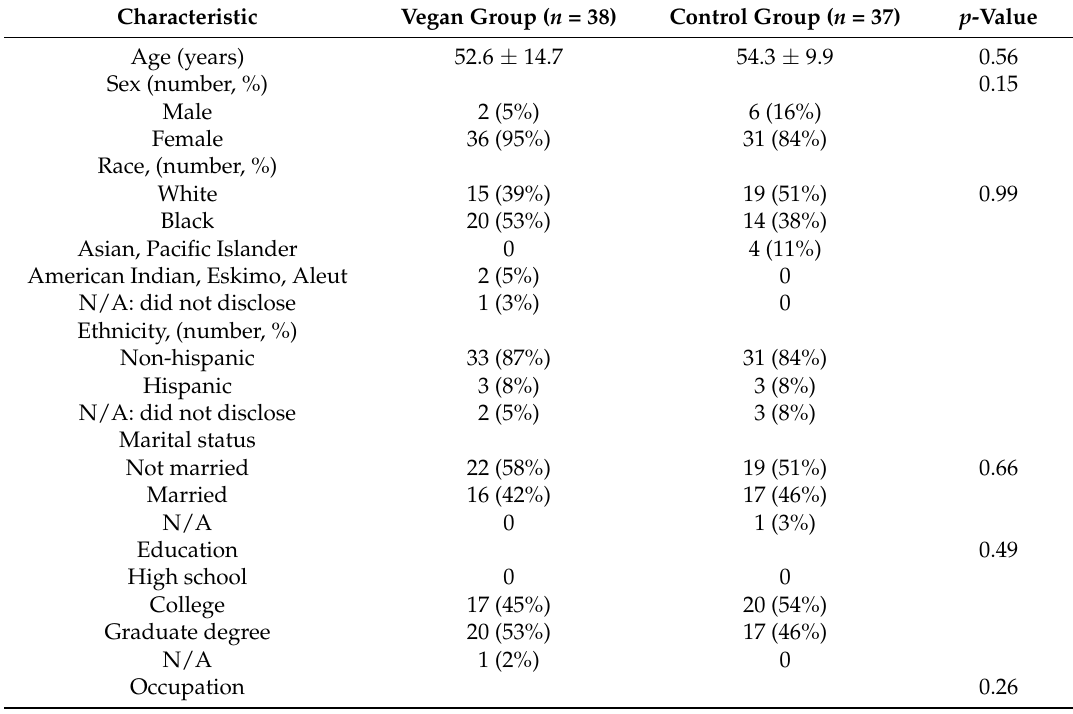
Figure 1. Enrollment of the Participants and Completion of the Study. Table 1. Baseline characteristics of the Study Population. Data are means ± SD, or number (%). p -values refer to t-tests for continuous variables and χ 2 for categorical variables. The p -value calculated for ethnicity distribution is for the comparison between Hispanic versus non-Hispanic categories.